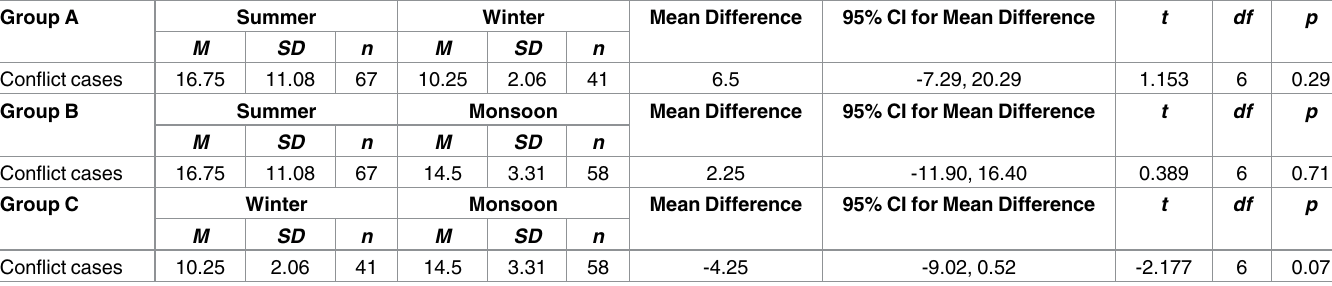
Table 1. Results of t-test for comparison of sloth bear encounters between two